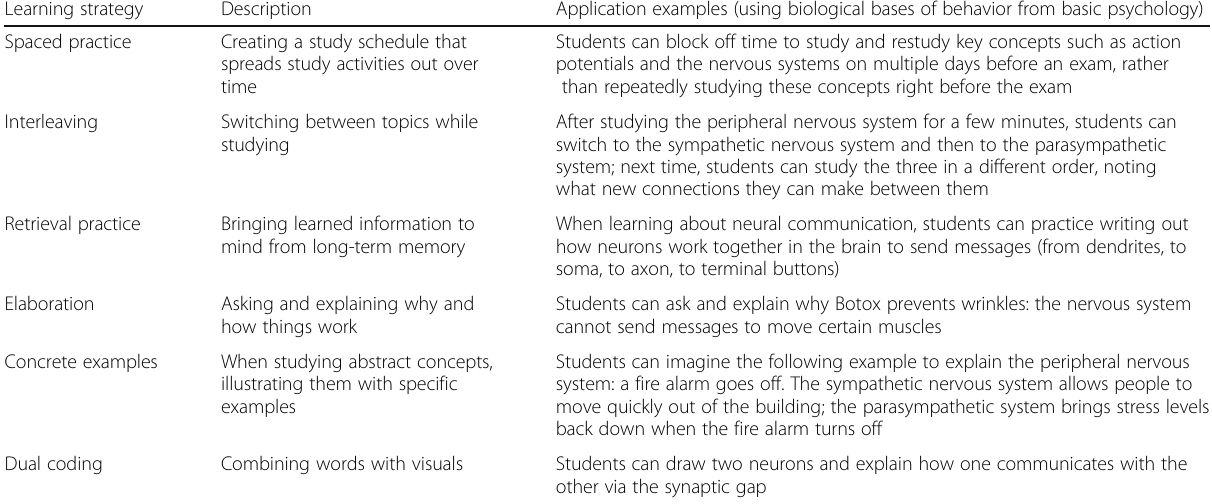
Table 1 Six strategies for effective learning, each illustrated with an implementation example from the biological bases of behavior Learning